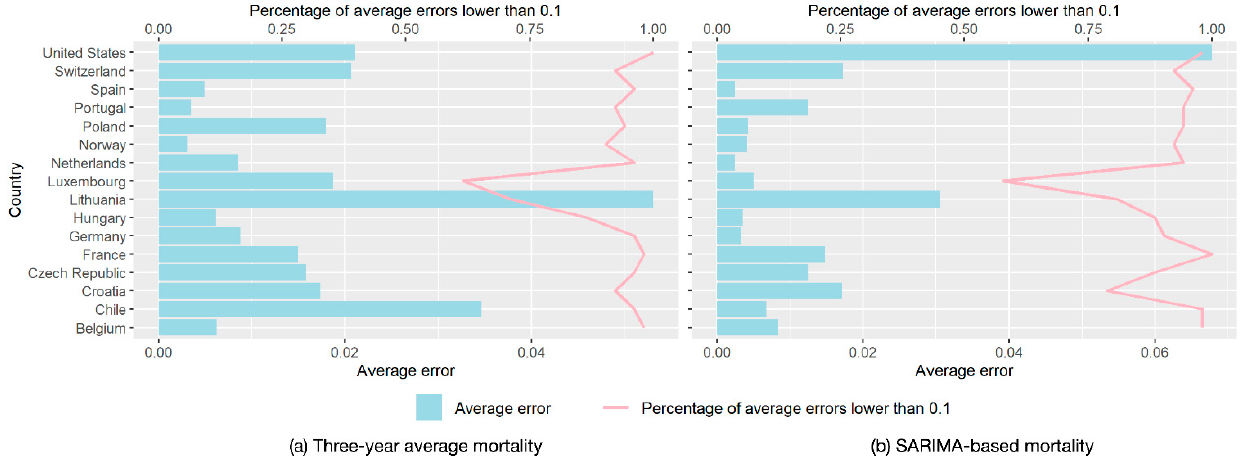
Figure 1. The performance of the three-year average mortality and SARIMA-based mortality estimations. (a) Three-year average mortality; (b) SARIMA-based mortality.